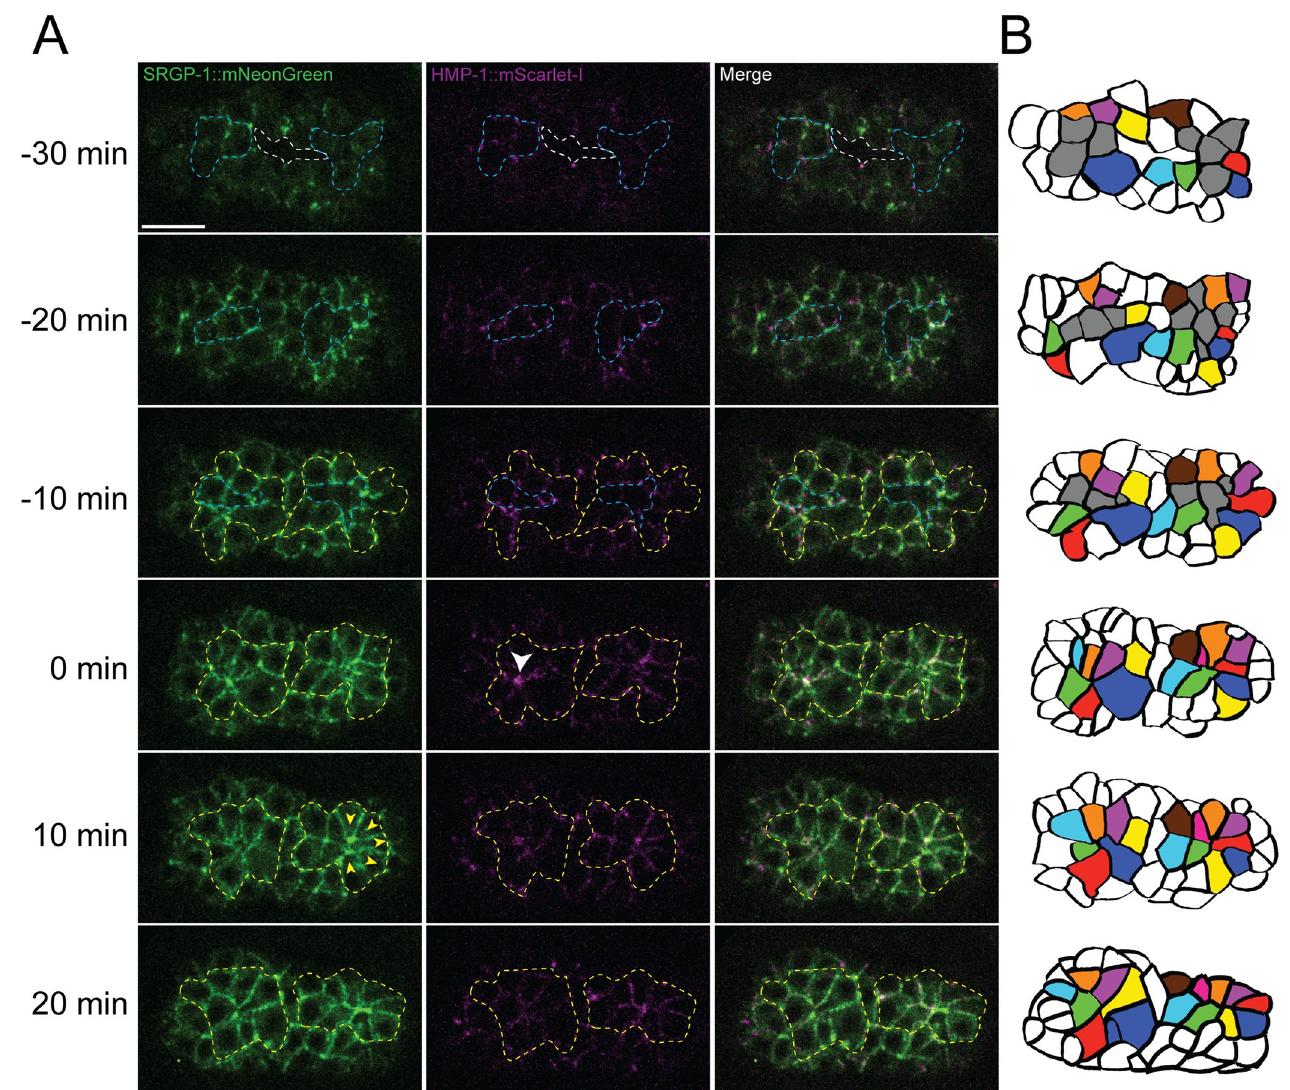
Fig 2. Rosette formation leads to cell rearrangement during cleft closure. (A) An embryo expressing SRGP-1::mNeonGreen and HMP-1::mScarlet-I before, during, and after anterior rosette formation (ventral view), showing the cell rearrangements that take place to seal the ventral cleft. Times are relative to formation of the anterior rosette (t = 0 min). Yellow dotted lines outline cells involved in rosette formation. Blue dotted lines indicate cells that internalize. White dotted lines indicate the ventral cleft. White arrowhead indicates the vertex of the anterior rosette. Yellow arrows indicate the direction of cell movement at the posterior end of the embryo following anterior rosette formation. (B) Cell tracings of the embryos in (A). Internalizing cells are colored grey, cells that form rosettes are colored, all other cells are white. Scale bar is 10 μ m.